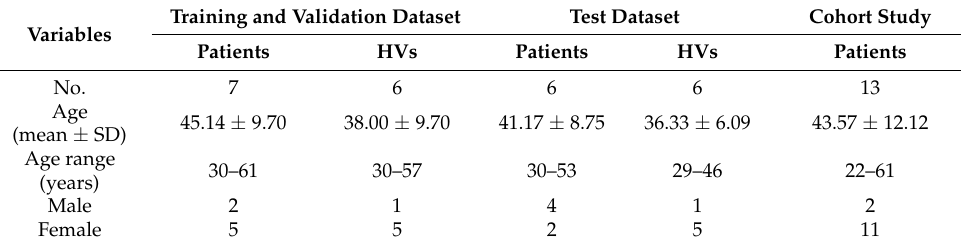
Table 1. Demographics of the participants in the training, validation, test, and cohort study.